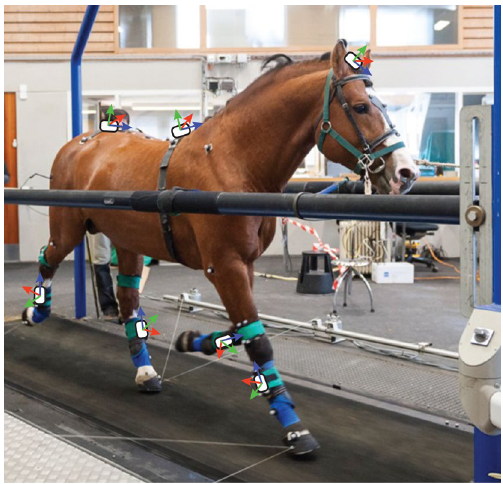
Figure 8. Horse on the TiF, equipped with reflective markers of the OMC system and the IMU nodes (white rectangles). Orientations of the nodes are shown with blue (x-axis), red (y-axis) and green (z-axis)